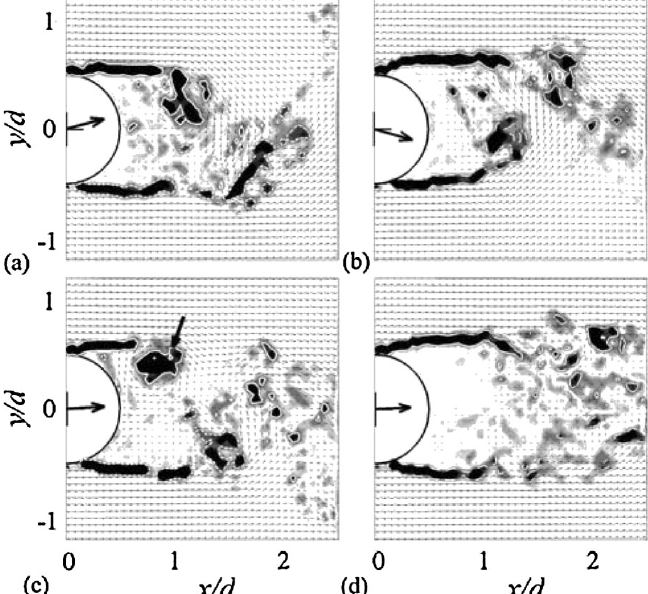
Figure 13. Instantaneous force vector acting on a cylinder and vorticity distributions around the FIG. 5. Vorticity contours with instantaneous force vector. cylinder subjected to short-duration (0.05 T K ) excitation from a single DBD-plasma actuator mounted Solid contours mark (cid:1) z d=U 1 ¼ (cid:1) 17 (clockwise rotation) while at θ A = 75 ◦ ; Re D = 1.5 × 10 4 , C F = 0.45%. ( a ) t / T K = − 0.8. ( b ) t / T K = − 0.3. ( c ) t / T K = 0.7. dashed contours mark (cid:1) z d=U 1 ¼ þ 17 (counterclockwise rota- ( d ) t / T K = 2.7. In this case, the pulse timing t 0 / T K = 0.875 is optimum for reducing drag and lift tion). Plasma activated at time t 0 =T K ¼ 0 : 875 , at location (cid:3) ¼